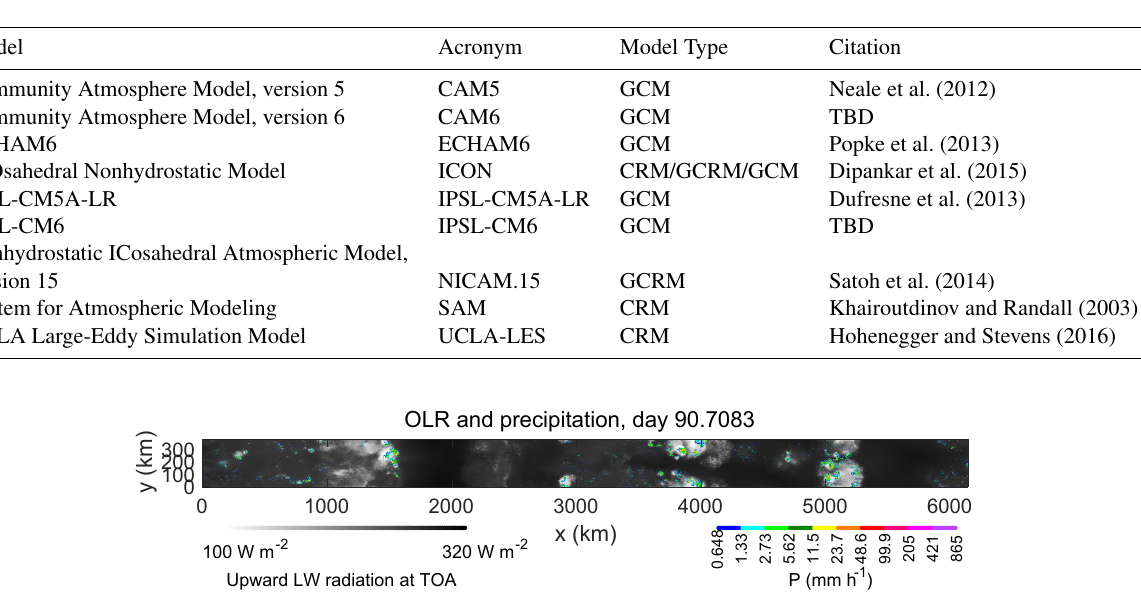
Table 8. Preliminary list of participating models.